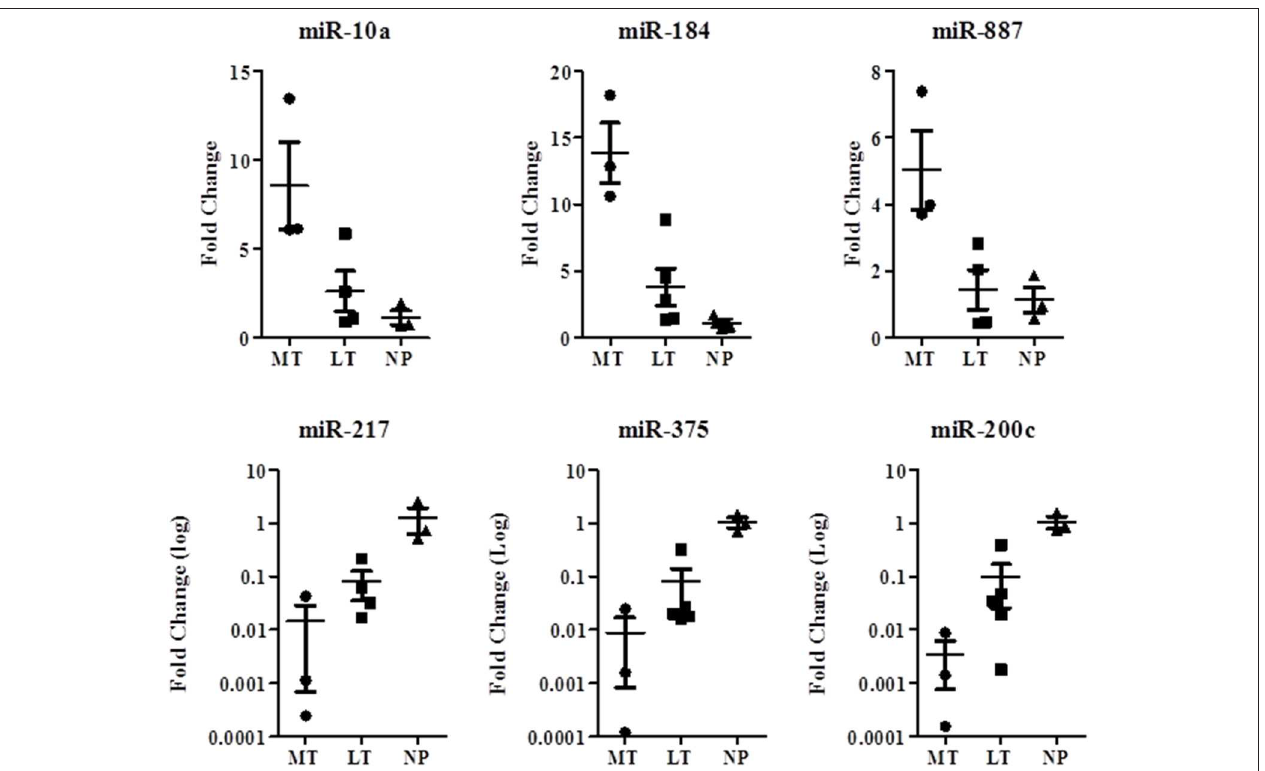
FIGURE 4 | MicroRNAs microarray validation study for comparison between localized and metastatic SPN microRNAs. Quantitative reverse transcription real-time PCR was performed to formalin-fixed paraffin-embedded blocks of SPN RNA extracted specimens from 5 localized tumors (LT) (n), 3 metastatic tumors (MT), and 3 normal pancreatic tissues (NT). P < 0.05.